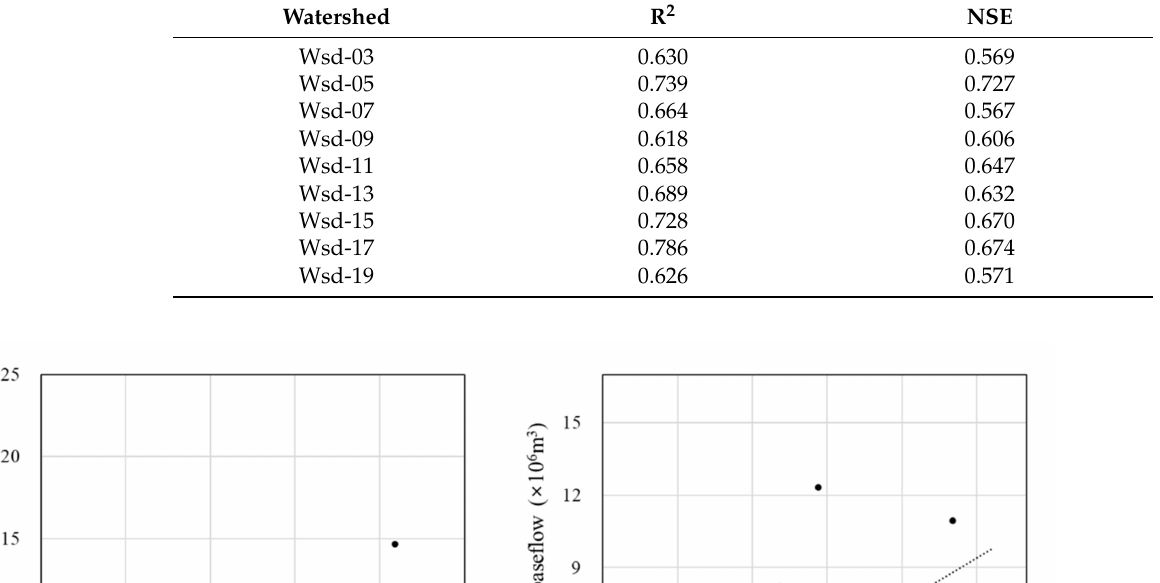
Table 6. R 2 and NSE of separated and estimated monthly baseflow in the second watershed group.